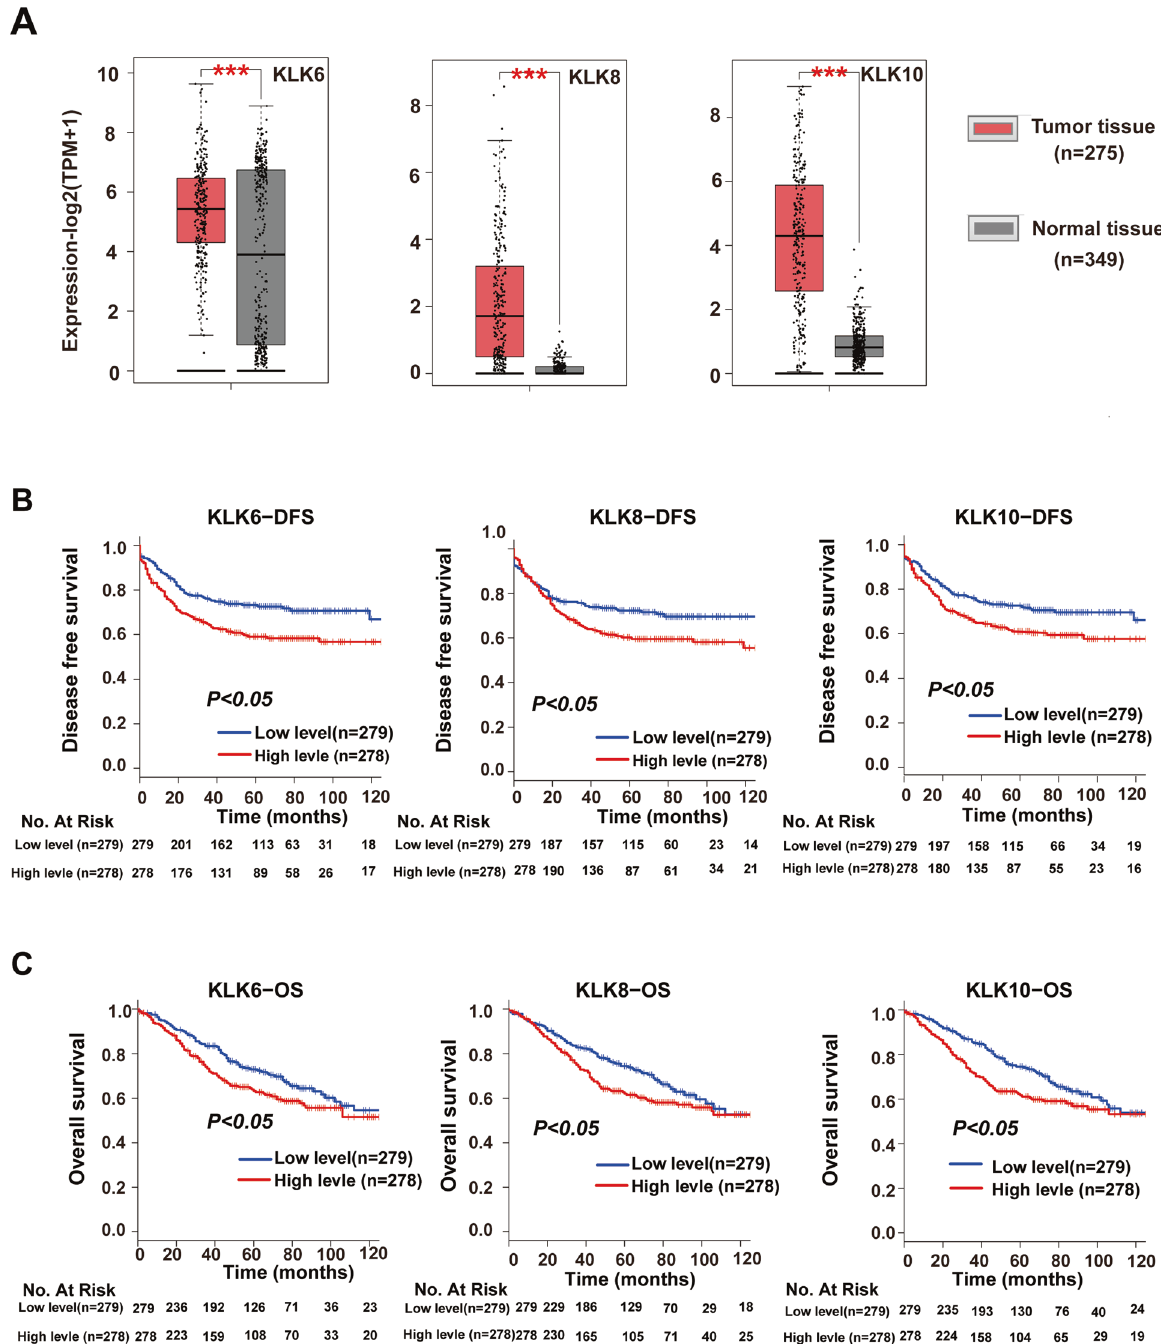
Fig. 1 The role of KLKs in the CRC. A The expression of KLK6, KLK8 and KLK10 in CRC tissues ( n = 275) and normal tissues ( n = 349) analysed in the TCGA and GTEx databases. B , C Disease-free survival (DFS) ( B ) and overall survival (OS) ( C ) were compared between patients with low and high KLK6, KLK8 and KLK10 expression in the GSE39582 database. *** P <